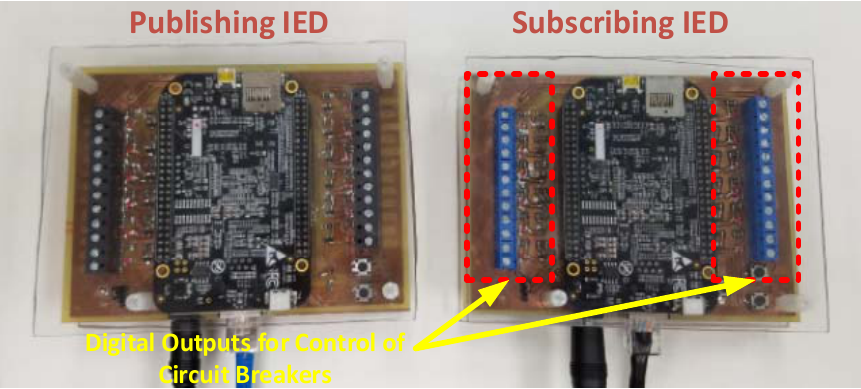
Figure 5. Experimental Setup with libiec61850 Implemented on Embedded Boards.